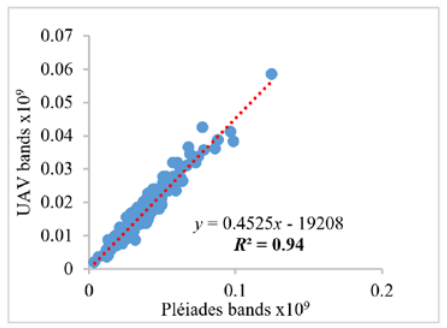
Figure 8. The relationship between spectral data between the UAV and Pléiades bands (×10 9 ). Table 6. Basic errors of CSA and volume based on extrapolated data.